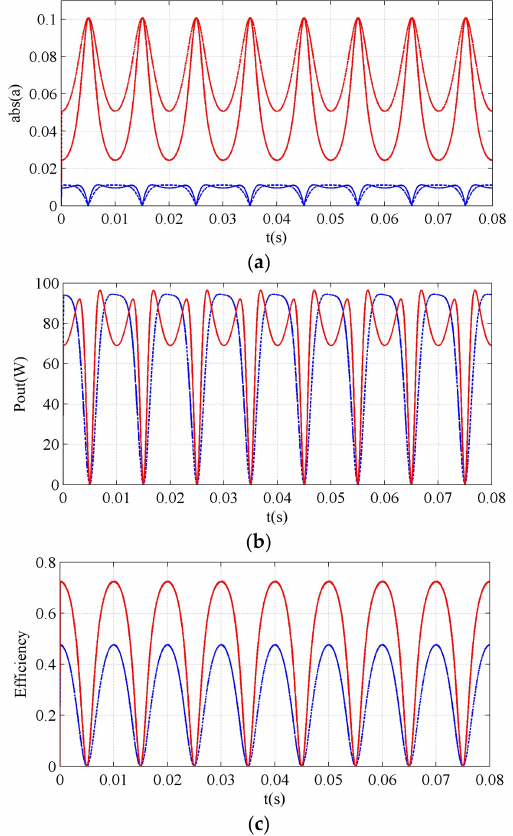
Figure 7. Waveforms of the abs( a s, 1 ), output power and transfer efficiency against time in the single-receiver system: ( a ) abs( a s, 1 ); ( b ) output power; ( c ) transfer efficiency.